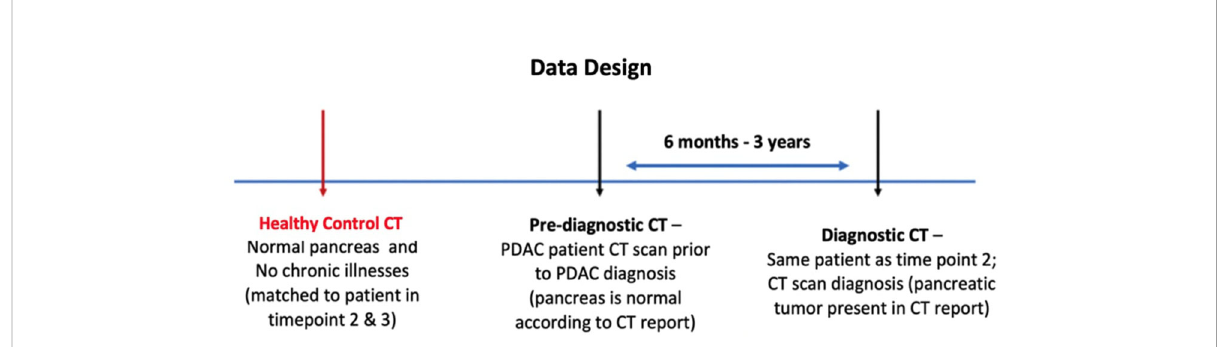
FIGURE 1 Proposed design of the data for the study. Each case in the dataset consists of three types of abdominal CT scans: Healthy control, Pre- diagnostic, and Diagnostic. The Pre-diagnostic and Diagnostic scans were obtained from the same